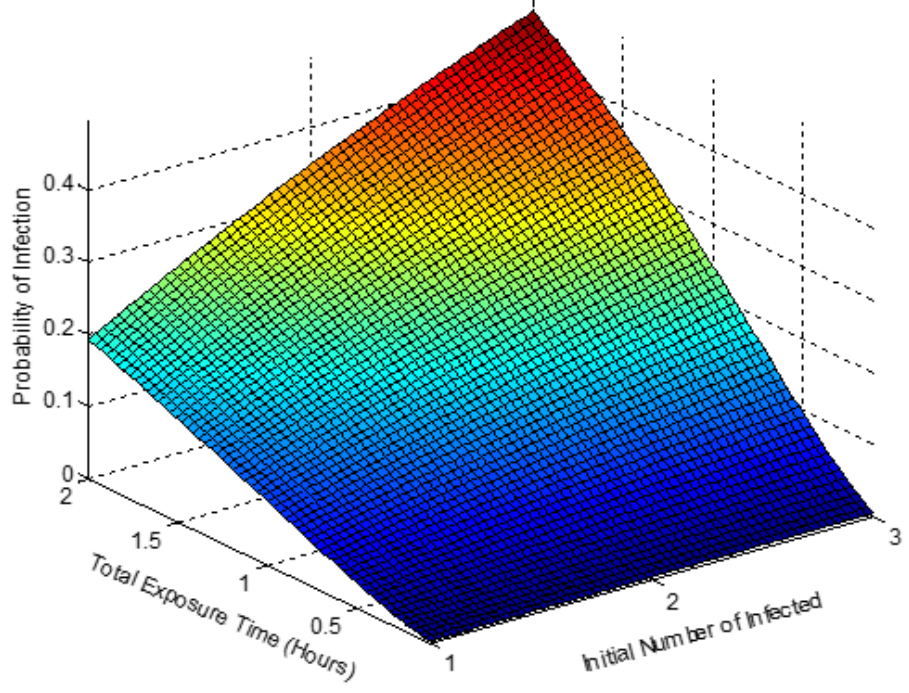
Figure 5. The probability of infection in a public bus with 20 passengers shown as a function of the total exposure time and the initial number of infected.